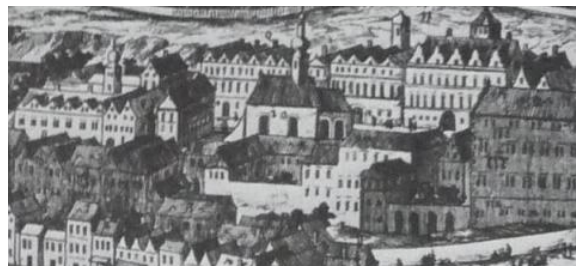
Figure 2. Carmel Monastery - View of Prague by